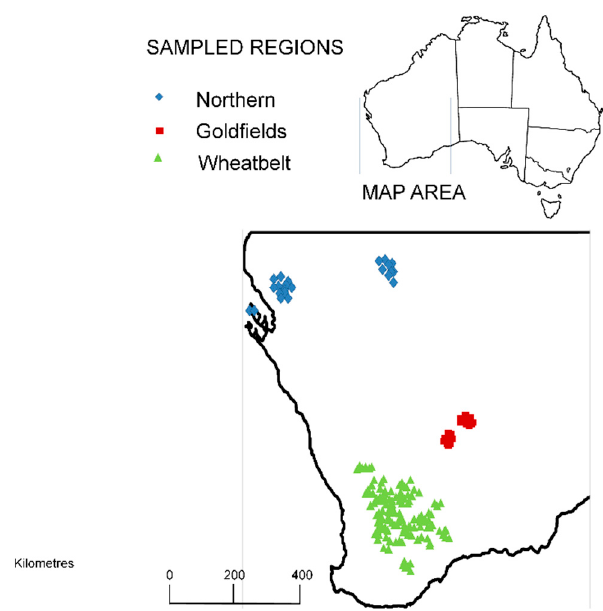
Figure 2. Map of Western Australia showing locations for collection of 194 S. spicatum heartwood- cores for chemical